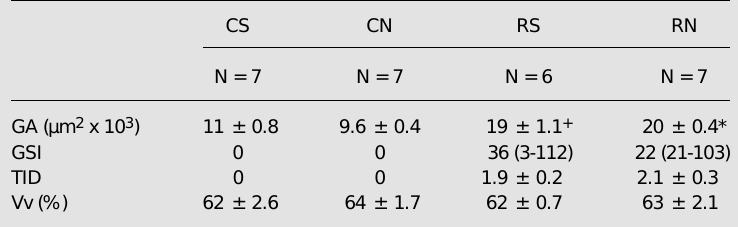
GA = glomerular area, GSI = glomerular sclerosis index, TID = tubulointerstitial dam- age, Vv = mesangial fractional volume, C = control, R = 5/6 renal mass reduction, S = linoleic acid-rich diet, N = normal linoleic acid diet. Data are reported as means + SEM or as medians. + P<0.02 compared to CS; *P<0.02 compared to CN (Duncan test for all parameters and Mann-Whitney for